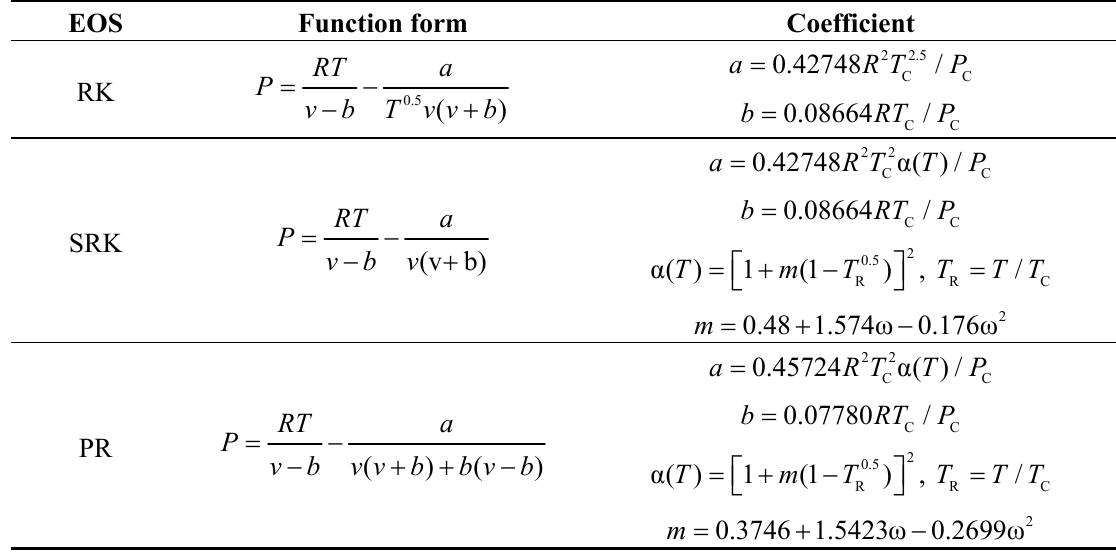
Table 1. Summary of studied equations of state (EOS) for N 2 /CO 2 . RK: Redlich-Kwong; SRK: Soave-Redlich-Kwong; and PR: Peng-Robinson.